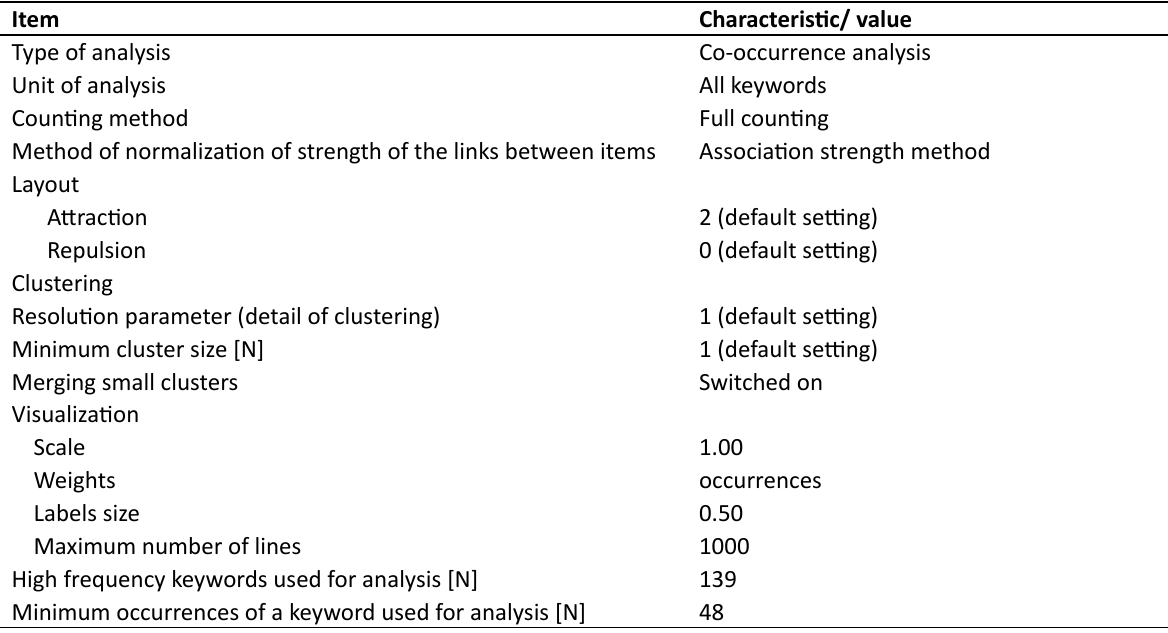
Table 2. VOSviewer parameters used for